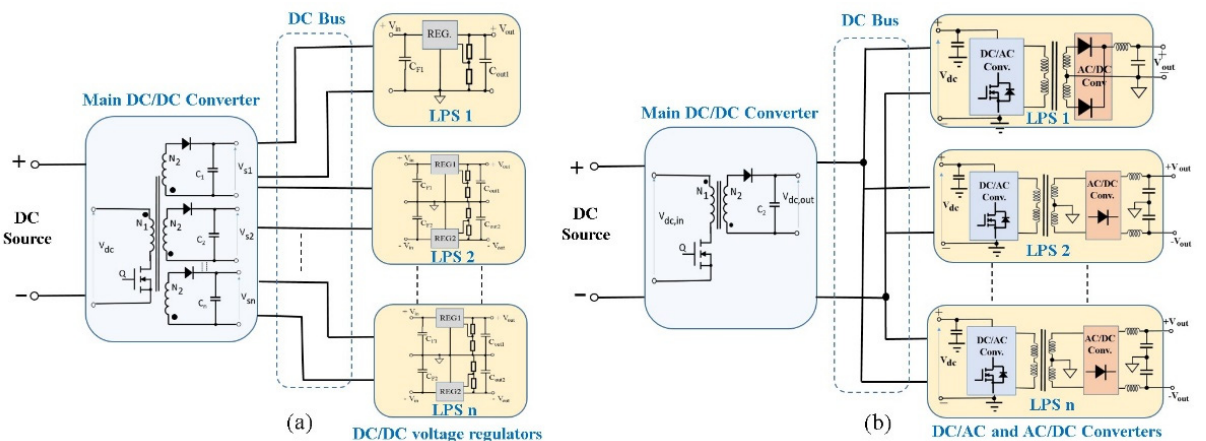
Figure 1. Typical distributed auxiliary power supply architecture with a main DC/DC converter with multiple output voltages and several LPS powering different kinds of low-voltage loads. ( a ) Multi-output isolated converter through a Flyback solution. ( b ) Single output DC/DC converter solution. In Figure 1a, a multi-output isolated converter through a Flyback solution is consid- ered. The multi-output solution (single magnetic core with several outputs) optimizes costs and saves components. However, it does not guarantee a fine regulation of all the load power supplies (especially if it has different voltage requests between the various channels) [21]. The multi-output solution requires a weightier design and a lower main DC/DC converter output voltage quality. Every LPS requires a linear LDO (or not isolated DC/DC switching converter). The single output DC/DC converter solution [22],